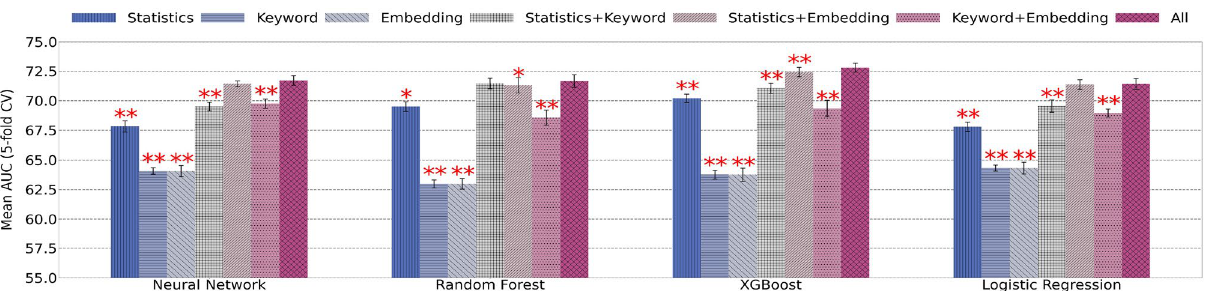
Figure 5. AUC scores for classifiers tested using different feature combinations. Each bar denotes clinical trial prediction result (AUC score) using one type of feature engineering method (or combination). Each group of bars (cluster) denote performance of one type of classifier. A single red star above a bar indicates a statistical difference with p < 0.05 , two red stars indicate p < 0.01 , compared to the models trained using all